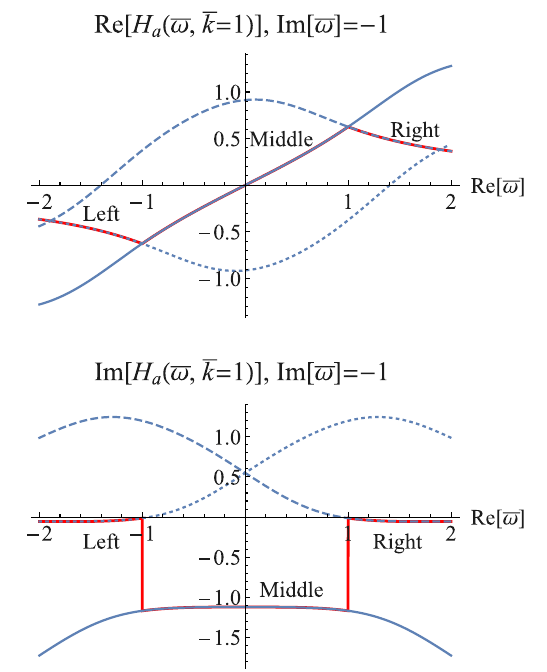
Fig. 8 Real and imaginary part of the function H a , defined in the Left (Re ( ¯ ω) < −¯ k ), Middle ( −¯ k < Re ( ¯ ω) < ¯ k ) and Right ( ¯ k < Re ( ¯ ω) ) part of the complex plane and analytically continued into the other regions of the ω -plane. The red curves indicate the function for a choice of the two branch cuts that pass Re ( ¯ ω) = ± 1 at Im ( ¯ ω) = − 1. Deform- ing the branch cuts amounts to varying the positions Re ( ¯ ω) at which the different analytical patches of H a are interfaced